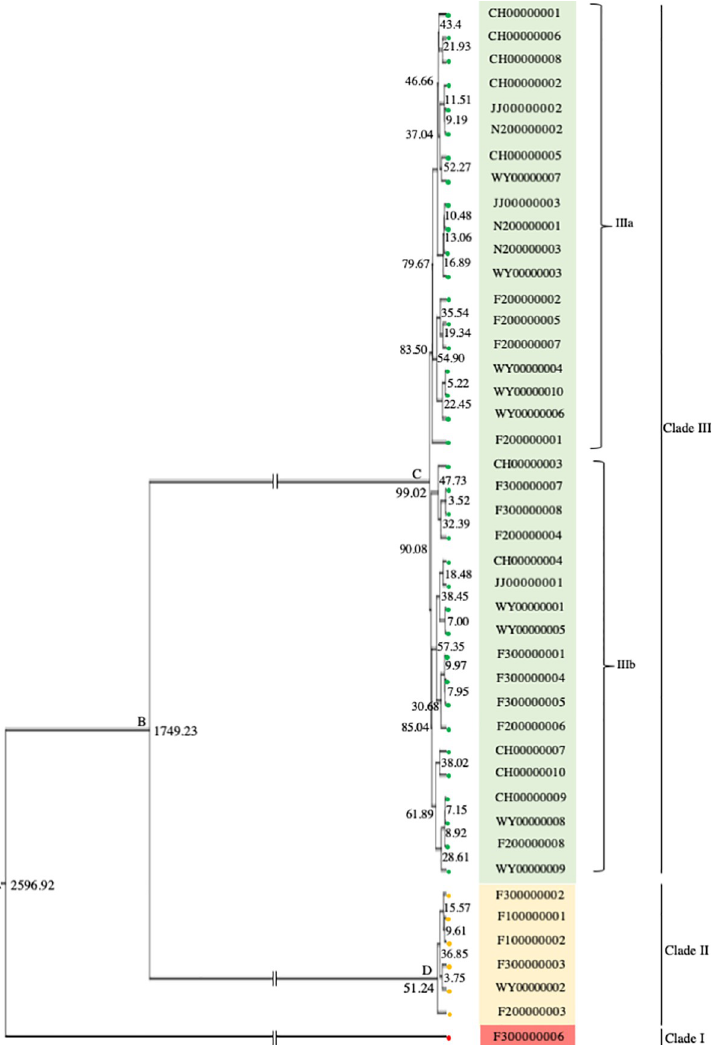
Fig 6. Divergence-time estimation of bat alphaCoV based on the nucleotide-substitution rate per site per year of the RdRp gene of coronavirus. The time-scaled phylogenetic tree summarizes all MCMC phylogenies of the RdRp gene data set, analyzed under HKY+G and Coalescent constant size models in BEAST software, version 2.6.0. The number at each node indicates the divergence time (years